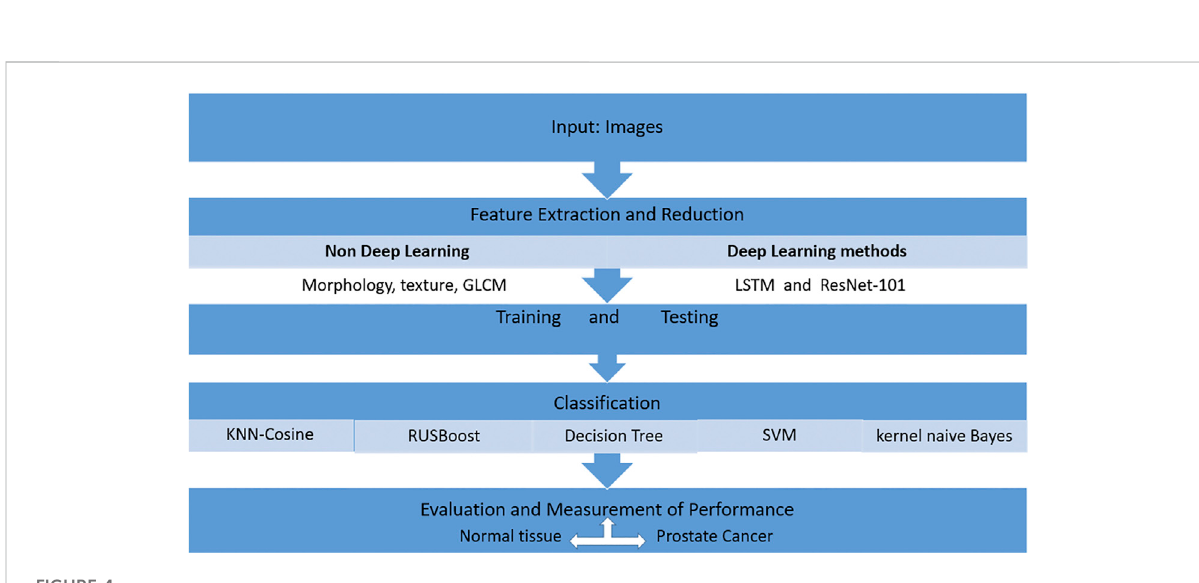
FIGURE 4 Model using the correlation feature selection method and random committee model